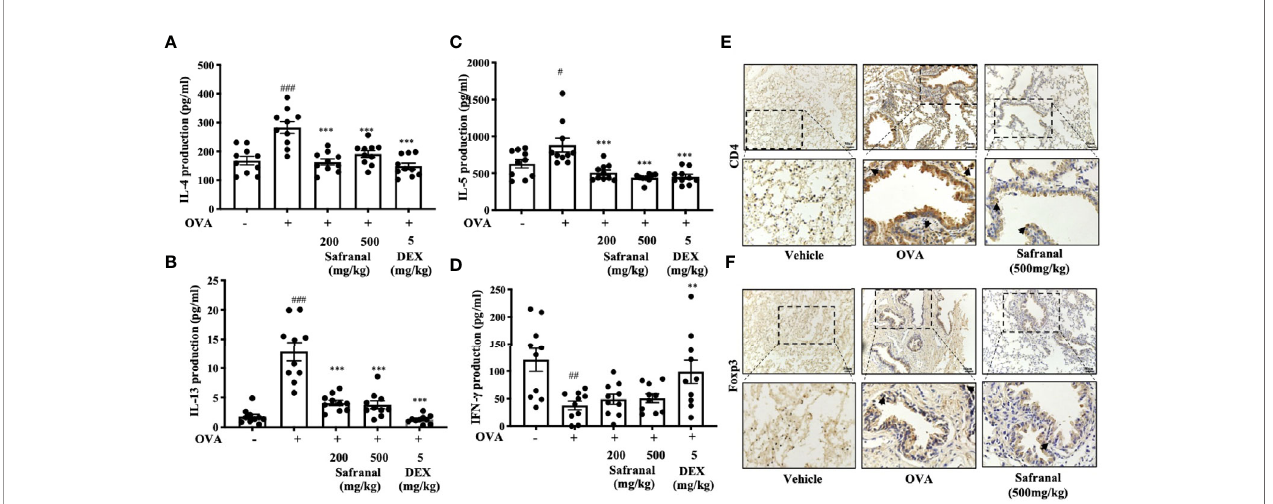
FIGURE 3 | Effect of Safranal on Th1/Th2 cytokines and T cells in lung tissues. Safranal decrease the level of IL-4, IL-5, IL-13 (A – C) in lung tissues, while IFN- g level increased (D) . Effect of safranal on T cell in lung tissues. (E, F) IHC staining of CD4 and Foxp3. The result showed decreased of CD4 and Foxp3 in safranal treated group. The data are presented as the means ± S.E.M. of n = 10. # p <0.05, ## p <0.01, ### p <0.001 compared to nontreated group. ** p <0.01, *** p <0.001 compared to OVA treated group. The scale labels shown are 50 m